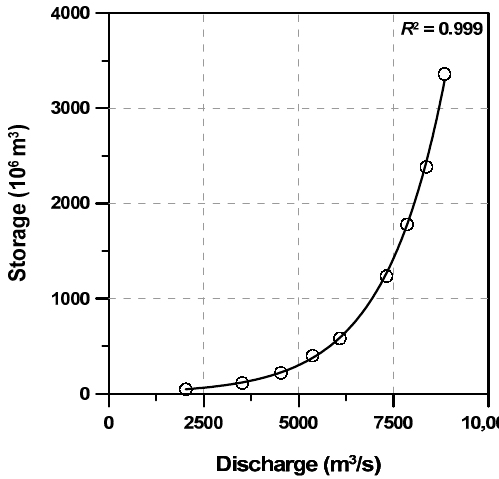
Figure 8. Curve fitting result for the discharge-storage relation of the current Peace Dam.